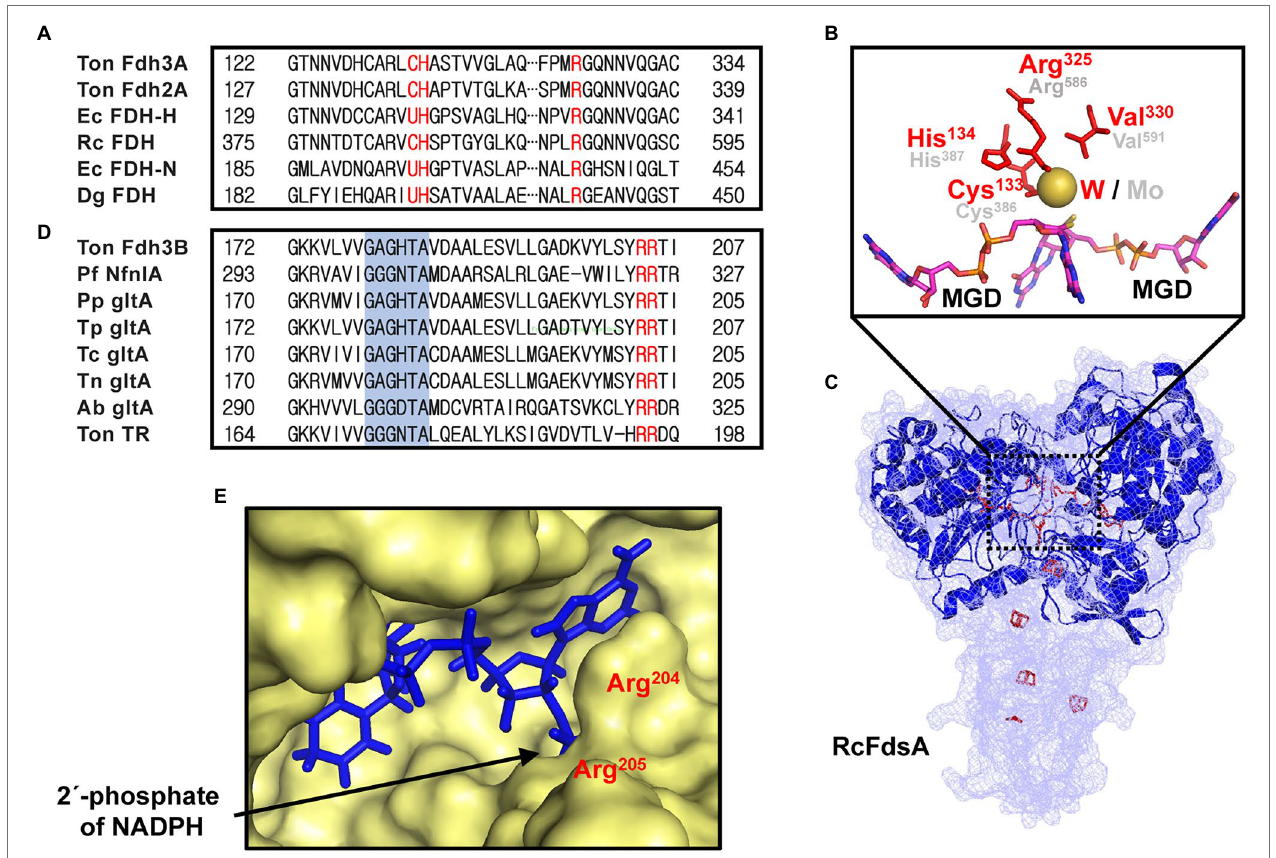
FIGURE 2 | Sequence-based analysis of Fdh3A and Fdh3B. (A) Multiple sequence analysis (MSA) of the Fdh3A homologs with the catalytic residues Cys 133 -His 134 - Arg 325 , shown in red. (B) SWISS-MODEL of Fdh3A using the RcFDH cryo-EM structure as a template with the conserved residues around metal ions shown in red (Fdh3A) or gray (RcFDH). (C) Structure modeling of Fdh3A using SWISS-MODEL (blue ribbon) aligned with RcFdsA (mesh) (PDB-ID: 6TGA). Bis-MGD and Fe-S clusters of RcFdsA are marked in magenta and red, respectively. (D) MSA of homologs of Fdh3B with the FAD binding motif GXGXXG, shown in blue. (E) Fdh3B modeling using PfNfnI as a template with Arg 204 -Arg 205 residues surrounding the 2 ′ -phosphate of NADP (H) shown in red. Ton, Thermococcus onnurineus ; Ec, Escherichia coli ; Rc, Rhodobacter capsulatus ; Dg, Desulfovibrio gigas ; Pf, Pyrococcus furiosus ; Pp, Palaeococcus pacificus ; Tp, Thermococcsu piezophilus ; Tc, Thermococcus cleftensis ; Tn, Thermococcus nautili ; and Ab, Azospirillum brasilense